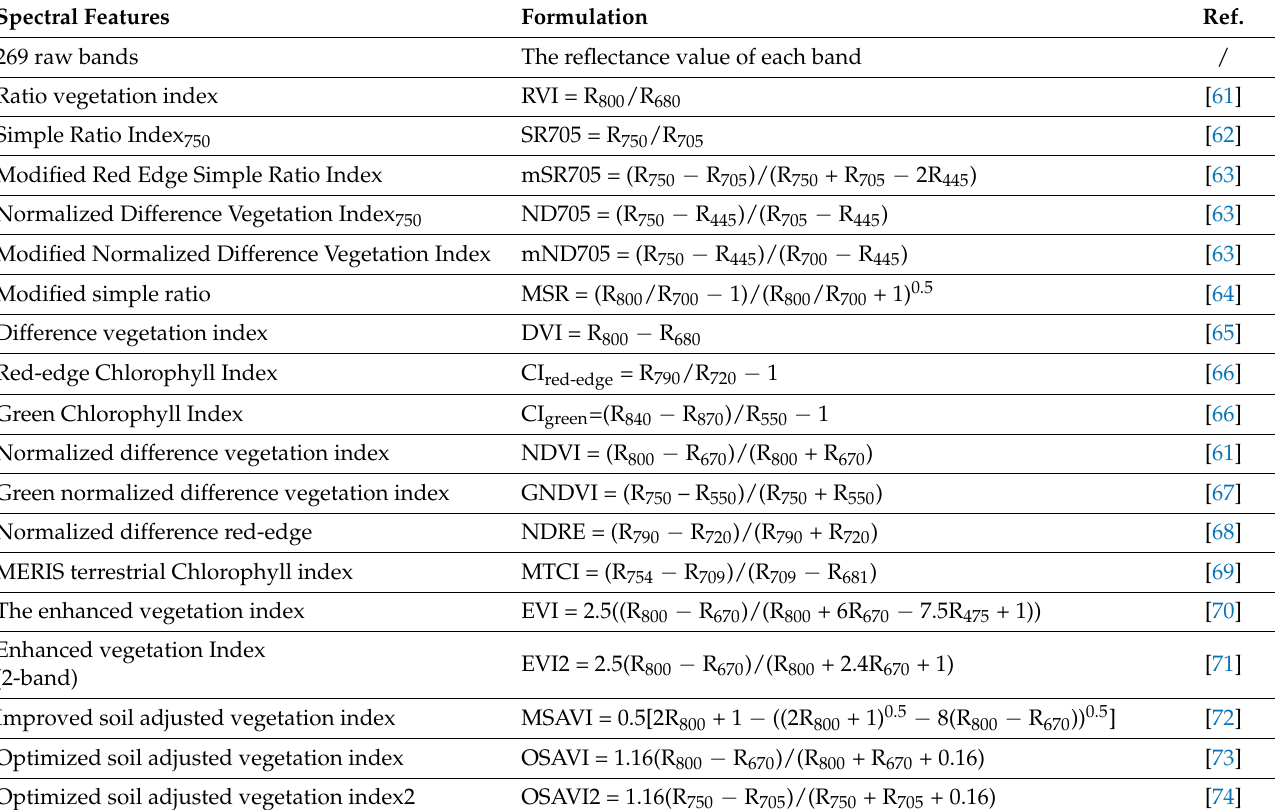
Table 3. Descriptions of spectral and structure features used for model